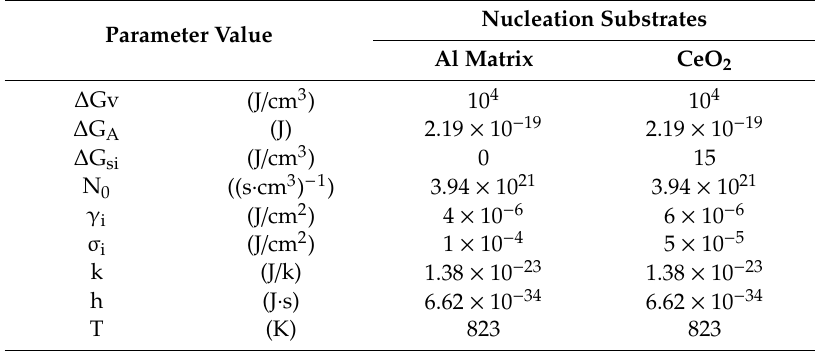
Table 2. The parameter value for the nucleation of precipitated Si on di ff erent nucleation